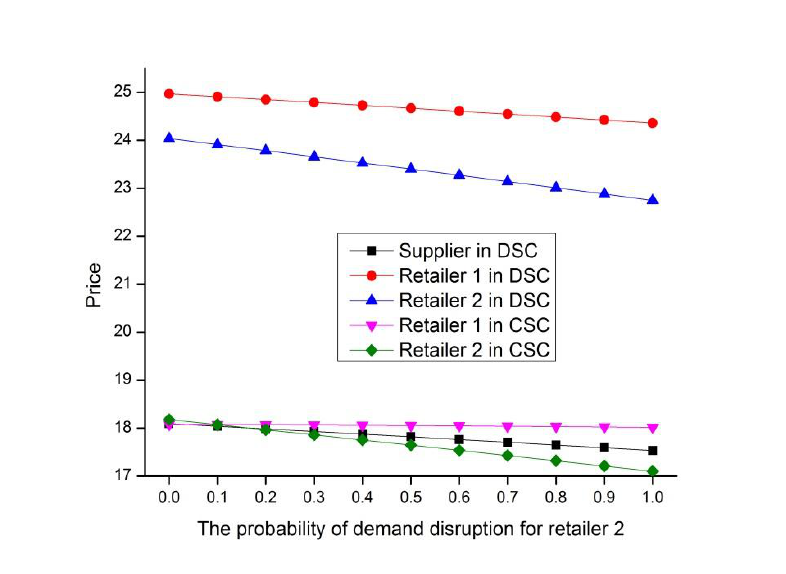
Figure 1. The optimal wholesale and retail price versus the probability of demand disruption for retailer 1